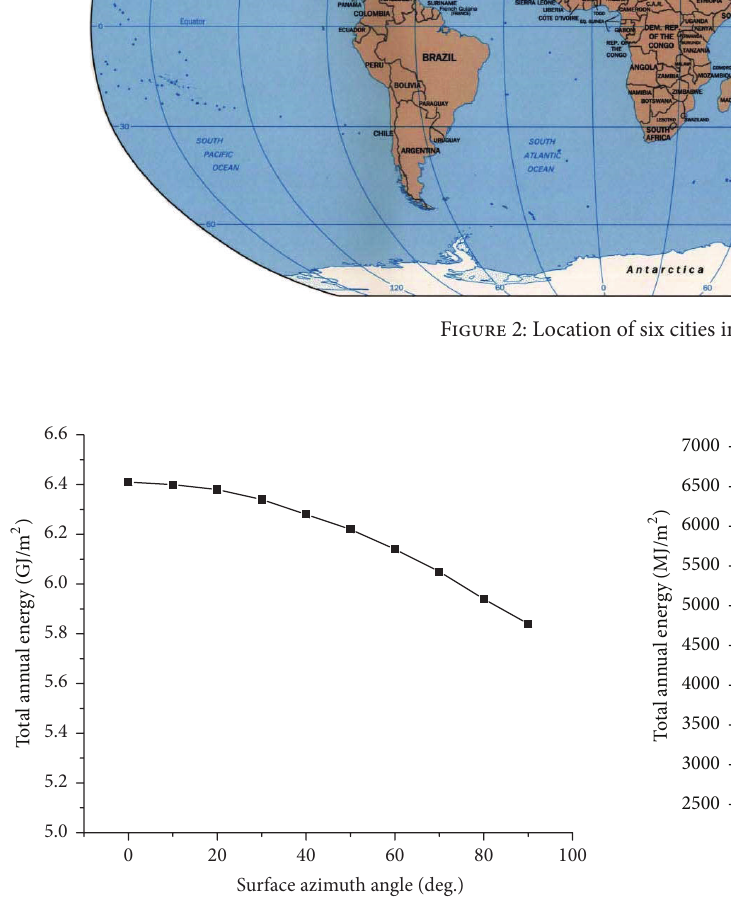
Figure 3: Effect of surface azimuth on solar radiation collection in Kunming.